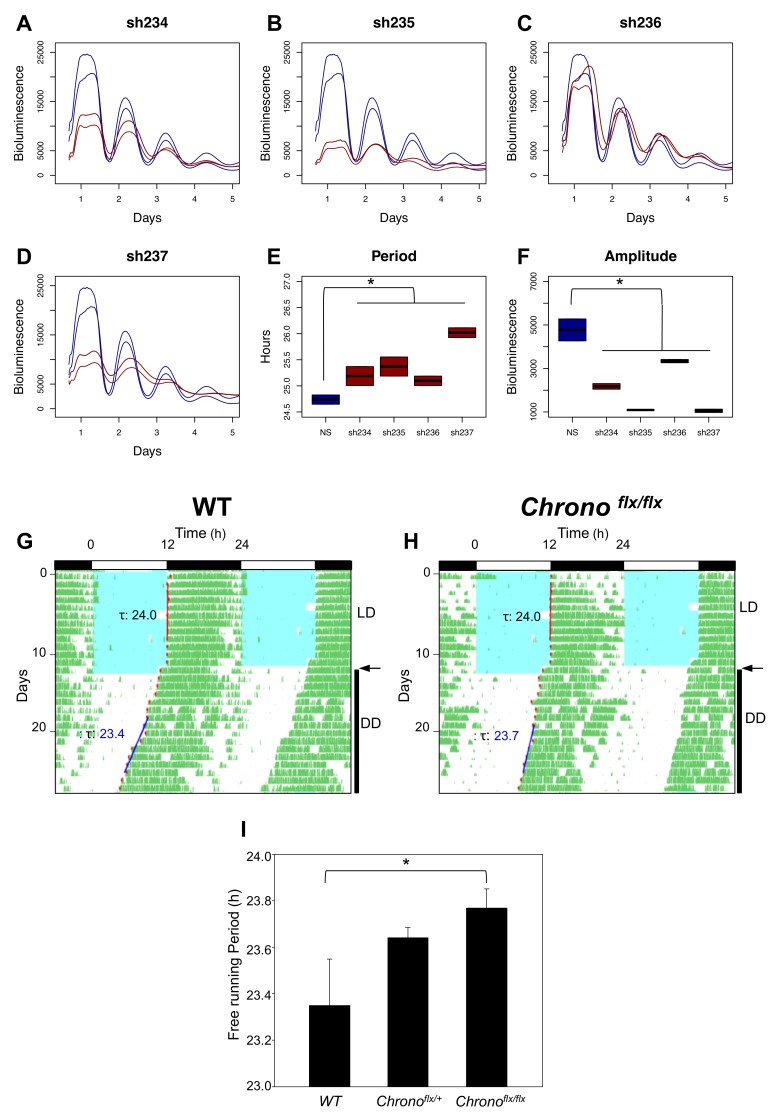
Influence of CHRONO on in vitro and in vivo rhythms.(A–D) Raw bioluminescence data from NIH 3T3 fibroblasts expressing BMAL:dLUC reporter are plotted after transfection with four shRNA constructs targeted against Chrono. Control and Chrono knockdown tracings are depicted in blue and red, respectively. Two replicates are shown. The period (E) and amplitude (F) of the observed rhythms are plotted. Representative wheel-running activity records for (G) wild-type control and (H) Chronoflx/flx knockout mice. Blue shading indicates light exposure during the initial 12∶12 h, L∶D cycle. Arrows indicate transition to constant darkness. Regression lines fit to activity onset and computed period are shown. (I) Periodogram estimates of observed periods from wild-type (n = 5), Chronoflx/+ (n = 8), and Chronoflx/flx mice (n = 6). Error bars indicate standard error of the mean.